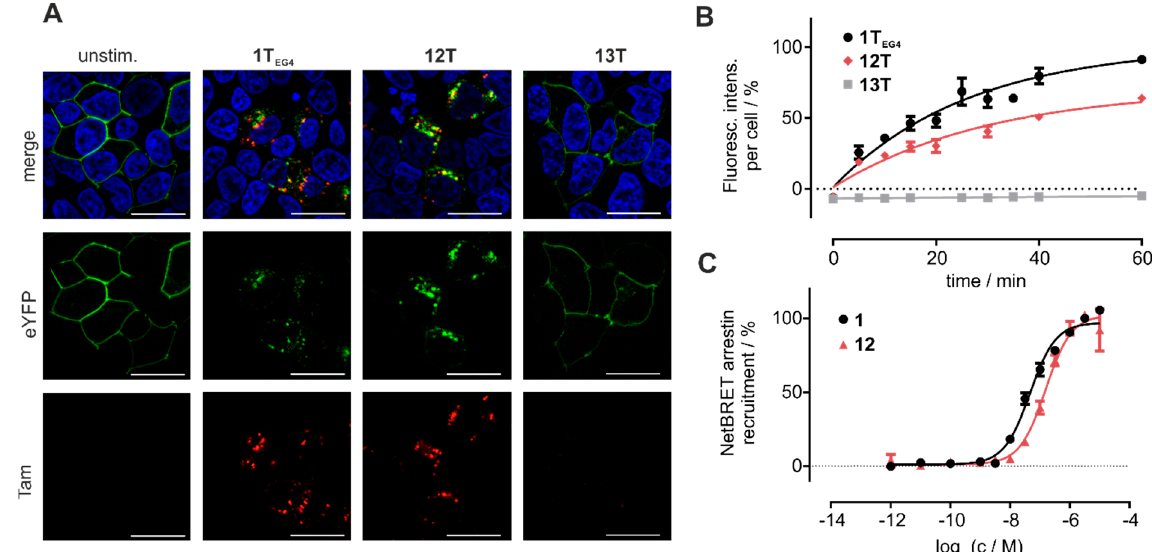
Figure 5. Cyclic chemerin-9 is internalized by cells expressing CMKLR1. ( A ) Live cell fluorescence microscopy of HEK293 cells transiently transfected with CMKLR1-eYFP. Cells were incubated with 1 µM of the respective, Tam-labeled peptide for 60 min. Intracellular Tam-fluorescence is visible after stimulation with the linear peptide 1T EG4 and the cyclic analog 12T , but not for the (A 8 ) mutant 13T . Representative images from at least two independently performed experiments are displayed. Scale bar = 10 µM, 63× magnification ( B ) The uptake of Tam-labeled peptides was quantified by measuring the intracellular accumulation of Tam-fluorescence in HEK293 cells stably transfected with CMKLR1-eYFP using a High Content Imager. The uptake of the cyclic peptide 12T is comparable to the linear peptide 1T EG4 , while 13T is not internalized over time. Data points represent mean ± SEM from at least two independent experiments performed in duplicates. ( C ) The linear peptide 1 and the cyclic derivative 12 induce arrestin3 recruitment to CMKLR1 as measured by a BRET-based arrestin-recruitment assay. Data points represent mean ± SEM from at least two independent experiments performed in quadruplicates.